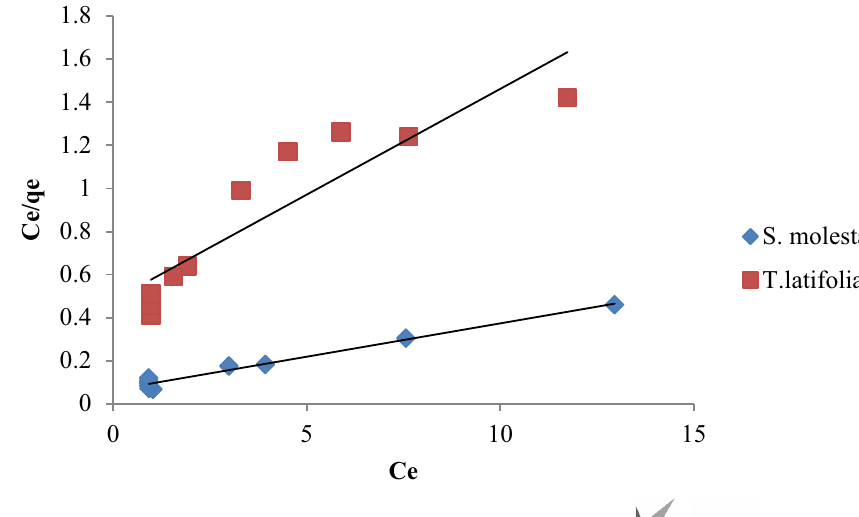
Fig. 10 Langmuir isotherm plot for Cr 6+ adsorption on S. molesta and T.